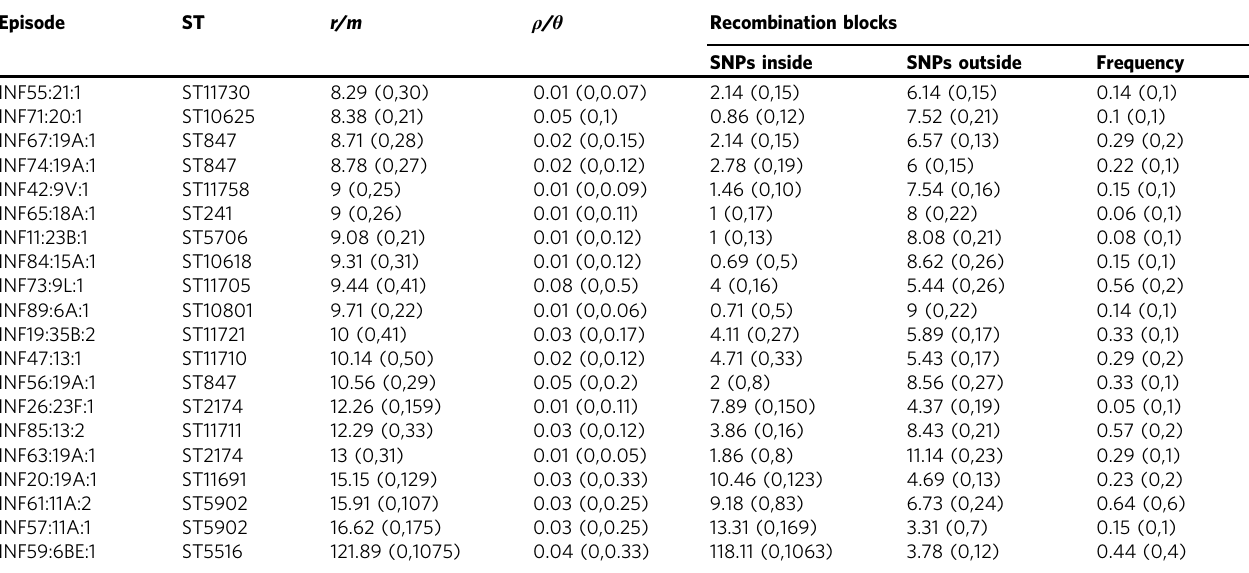
The episode name is shown in the format A:B:C where A,B and C represents the infant ID, serotype and number of episodes with the serotype respectively. The value of r/m represents the ratio of the numberof SNPsimportedby recombinationrelative tothosearisingthroughrandommutationoutside recombinationblocks. Thenumbersofrecombination block relativetothe numberof SNPsoutside the recombination blocks is denoted by ρ / θ . The values in brackets for the number of SNPs per branch and ρ / θ represents the range for the estimates. The estimates provided are for serotypes from colonisationepisodes whererecombinationwas detected anda minimumof 3sequenced genomeswereavailablefrom eachepisodeasrequired bythe recombination detectionprogram(Gubbins).The estimates for recombination for the other episodes are shown in Supplementary Data